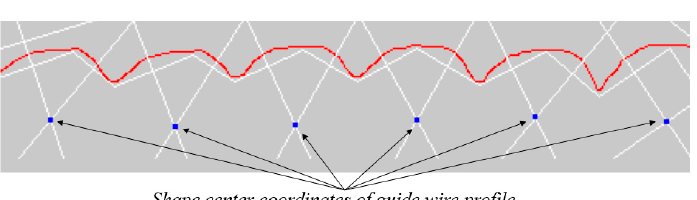
Figure 19. Shape center coordinates of guide wire profile.